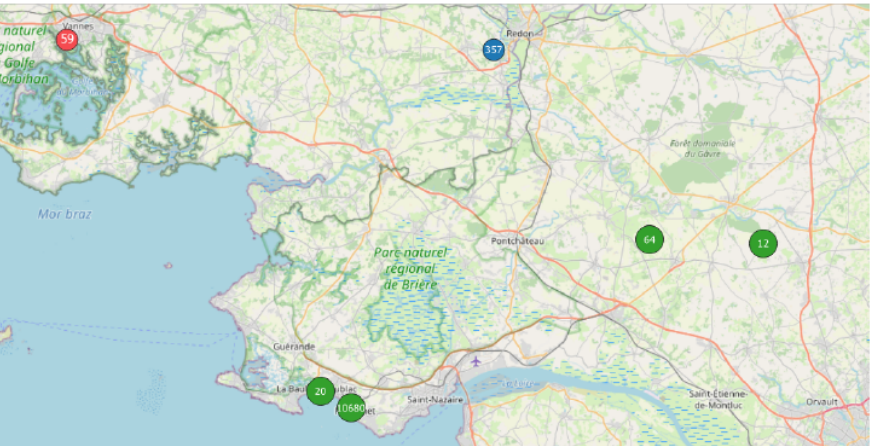
Figure 3. Measurement location for the NC party event Id N°1 (cf. Table 1). To simplify the representation, the points are grouped into 5 main zones. For each zone, the number of measurement points is indicated in the circle. In total, 11,192 geo-localized points have been collected during the official day of the event on 20 September 2017 (green circles), with additional points before (red circle, on 19 September 2017) and after (blue circle, on 23 September 2017) the official day. The collection points cover 2 administrative regions, “Pays de Loire” (20 + 10,680 = 10,700 points), which corresponds to the official spatial zone of the NC party, and “Britain” (59 + 357 + 64 + 12 = 492 points); represented area of approximately 44.0 km × 102.0 km.